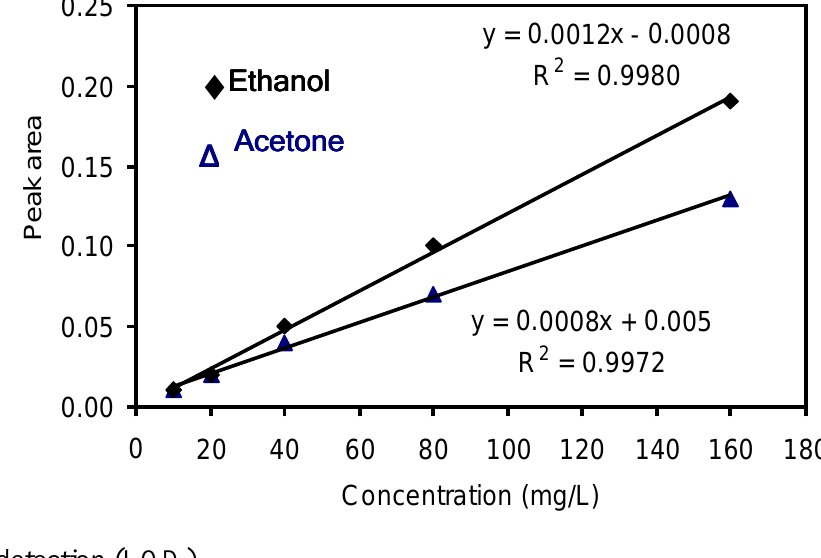
Figure 7. Calibration graphs of ethanol and acetone with injection volume of 1.0 m L